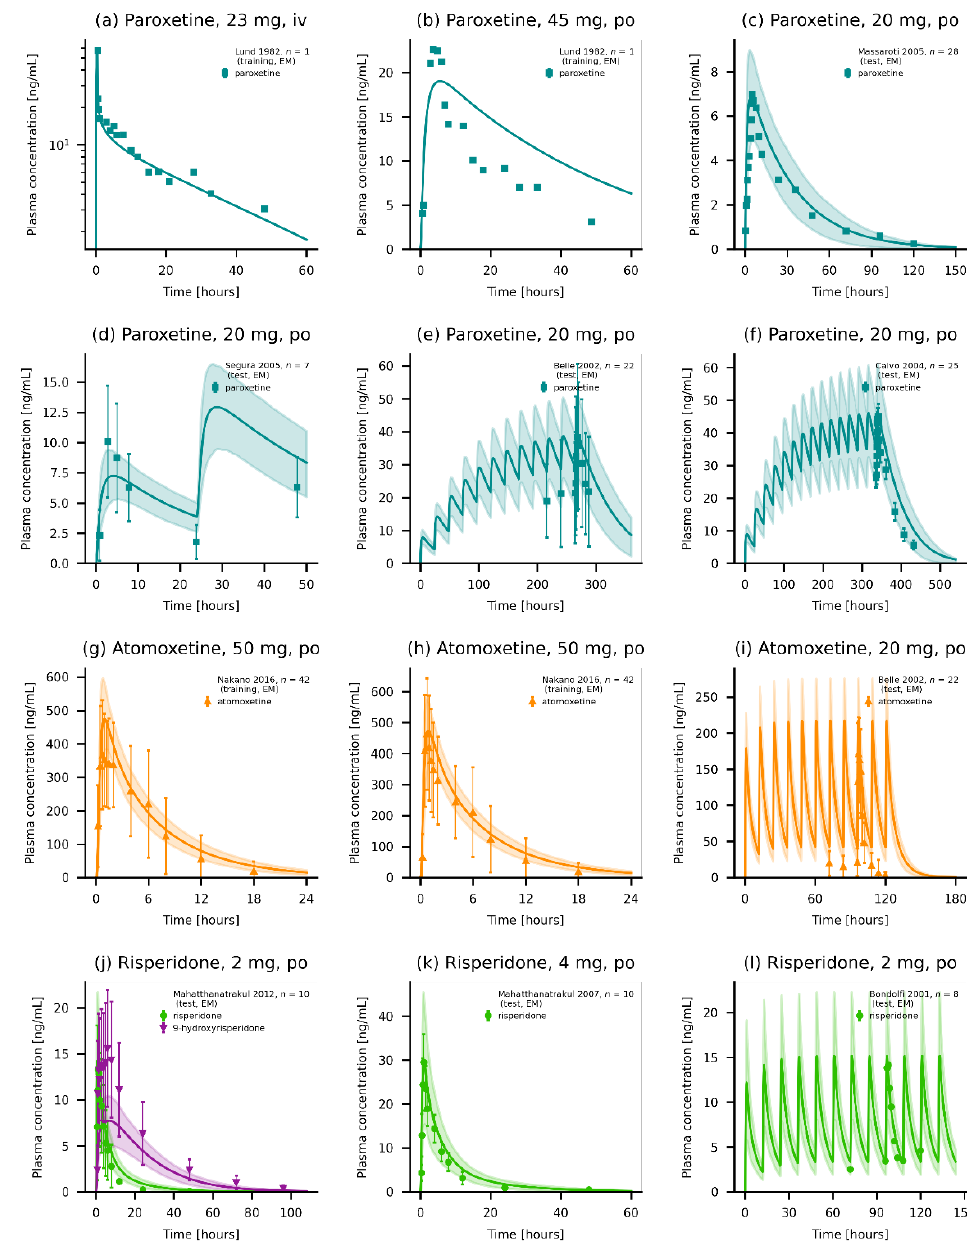
Figure 3. Plasma concentrations of the modeled compounds. ( a – f ) Model predictions of paroxetine of selected ( a – c ) single-dose administrations of ( a ) an intravenous infusion, ( b ) an oral solution, and ( c ) a normal release tablet. ( d – f ) Multiple-dose administrations of paroxetine as normal release tablets [25,26,28,29,35]. ( g – i ) Model predictions of atomoxetine as ( g , h ) single-dose administrations of ( g ) an oral solution, ( h ) a capsule and ( i ) multiple-dose administration of atomoxetine [25,44]. ( j – l ) Model predictions of risperidone and 9-hydroxyrisperidone (if available) of ( j , k ) single-dose administrations and ( l ) a multiple-dose administration of risperidone [47,51,52]. Individual predictions are shown as lines. Population predictions ( n = 1000) are shown as lines with ribbons (arithmetic mean ± standard deviation (SD)), and symbols present the corresponding observed data ± SD (if available). Detailed information on all clinical studies is listed in Section S2.1.2 [27,30,33,34,36 – 40], Section S3.1.2 [41 – 43,45,57] and Section S4.1.2 [48,49,53,54] of the Supplementary Materials S1. iv: intravenous, and po: